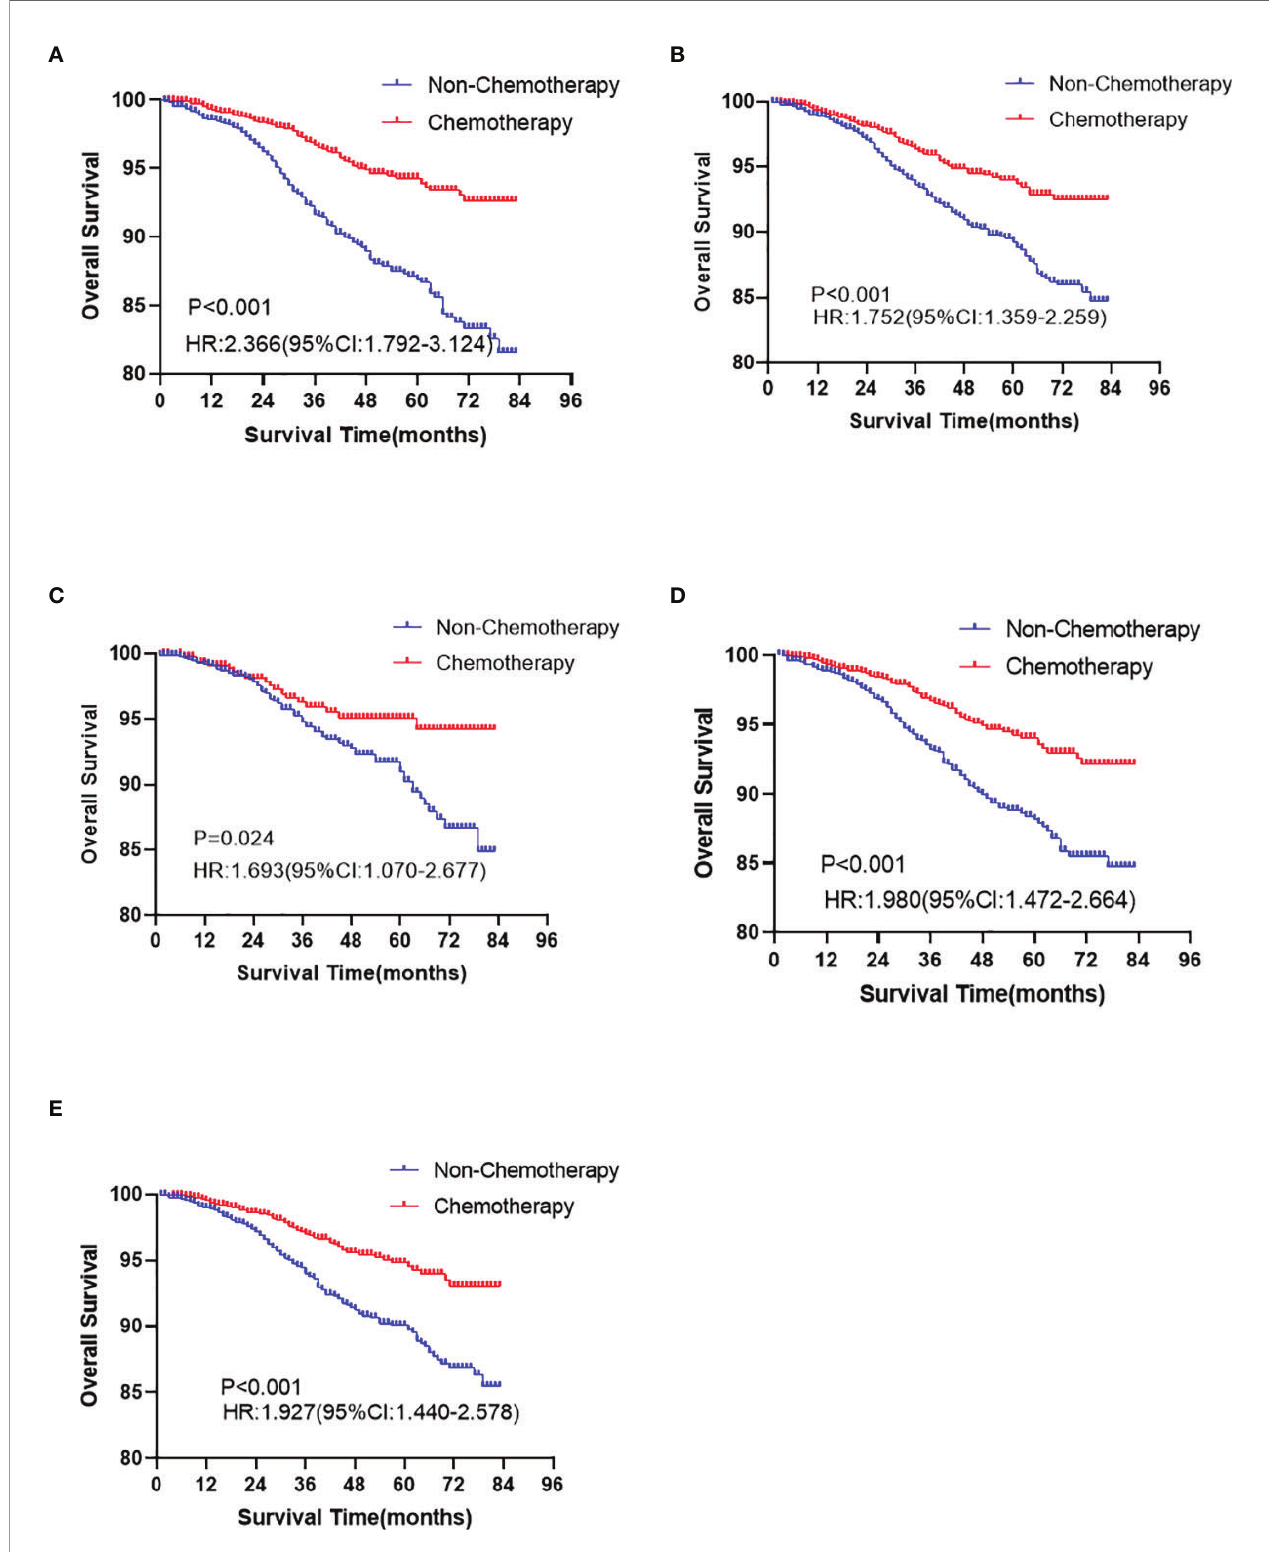
FIGURE 3 | The overall survival analyses for chemotherapy and non-chemotherapy group in T1b ( A P < 0.001), ≥ 50 years old ( B P < 0.001), grade II ( C P = 0.024), III/IV ( D P < 0.001), and White ( E P < 0.001) race subgroups in node-negative triple-negative breast cancer with tumor size less than 1